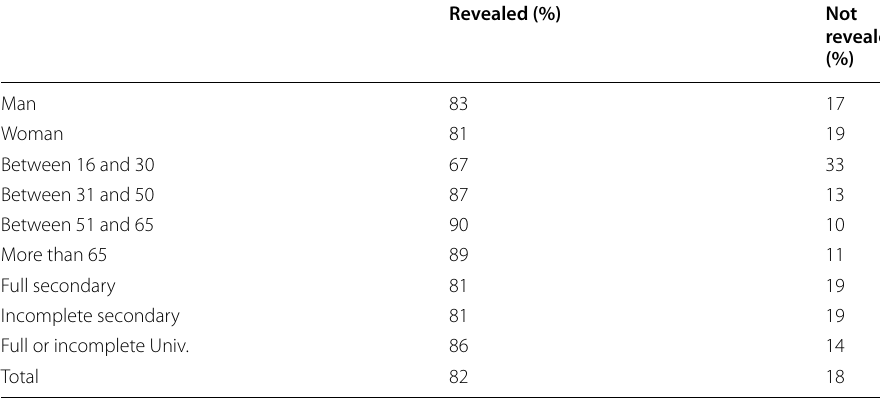
Revealed (%) Not revealed